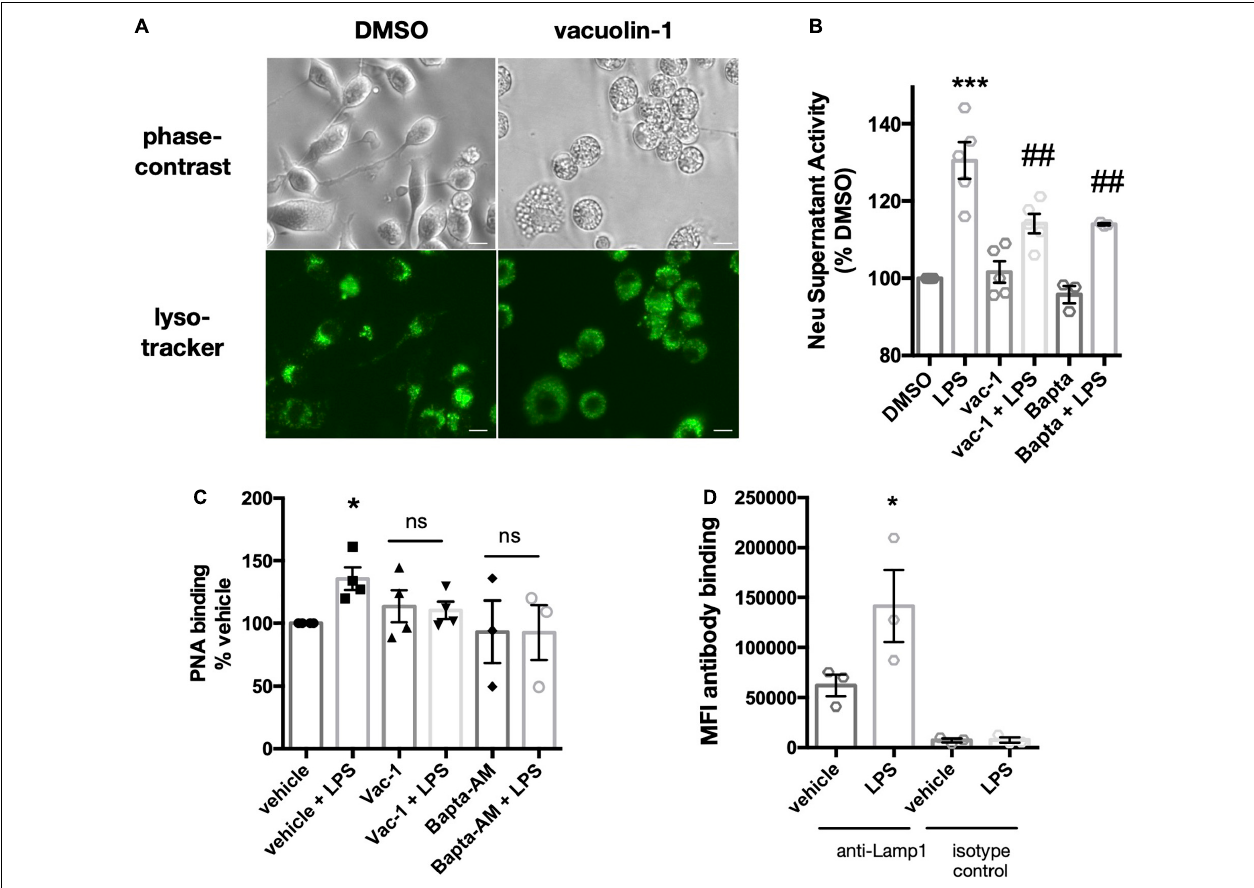
FIGURE 2 | Vacuolin-1 or BAPTA-AM block LPS-induced supernatant neuraminidase activity and surface desialylation. (A) Images of DMSO or vacuolin-1 (1 µ M, 1 h) treated BV-2 microglia, stained with lysotracker-green. Images acquired with an epifluorescence microscope (20x objective) and representative of three similar experiments. Top panel, bright field. Bottom panel, FITC/488-fluorescence channel. Scale bar – 10 µ m (B) Supernatant neuraminidase activity assays (pH 7.2) of vehicle or LPS-treated (1 µ g/ml, 6 h) BV-2 microglia. Cells were pre-treated for 1 h with inhibitors vacuolin-1 (400 nM) or BAPTA-AM (10 µ M). Data presented as mean fluorescence intensities of three independent BV-2 culture preparations ( ± S.E.M) normalized to DMSO control. Statistical analysis was performed on the original non-normalized data set: one-way ANOVA with Tukey’s post hoc analysis, *** p < 0.001 versus DMSO, ## p < 0.01 versus LPS. (C) Binding of the FITC-conjugated lectin peanut agglutinin (PNA) to BV-2 microglia as measured by flow cytometry. Data presented as fluorescence intensities normalized to DMSO control from n = 3 independent experiments. Statistical analysis was performed on the original non-normalized data set: one-way ANOVA with Tukey’s post hoc